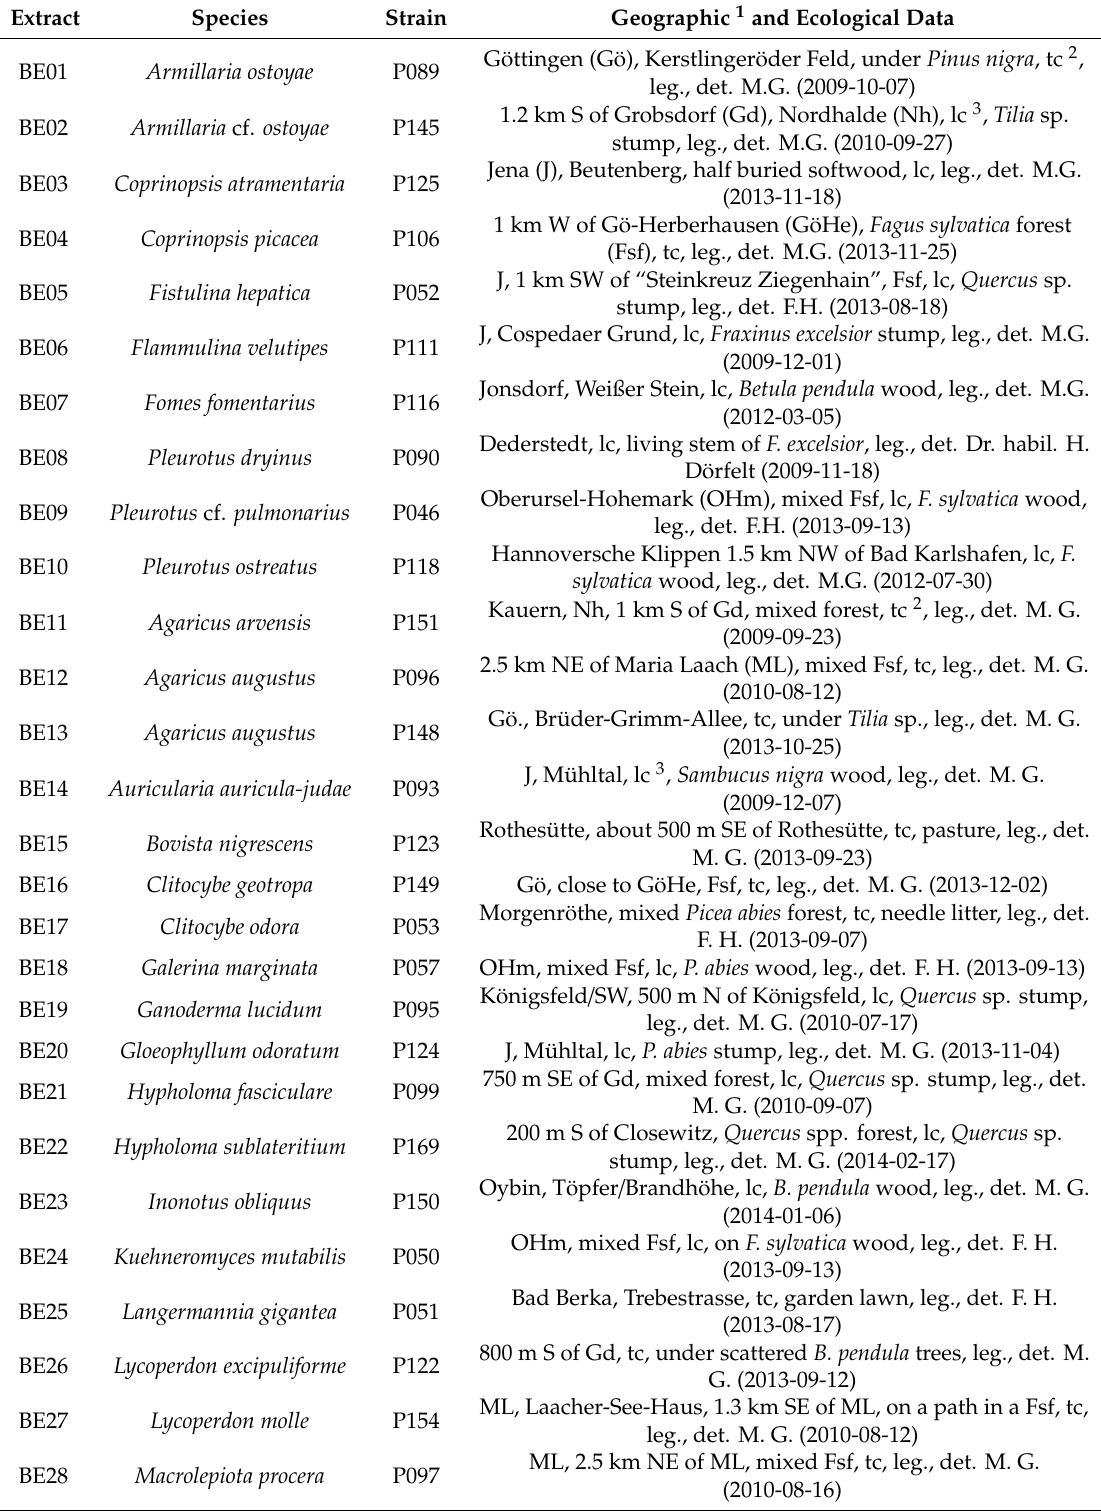
Table 1. Forty-one mushroom strain extracts (BE01-41) tested for potential antifungal bioactivity. Extract Species Strain Geographic 1 and Ecological